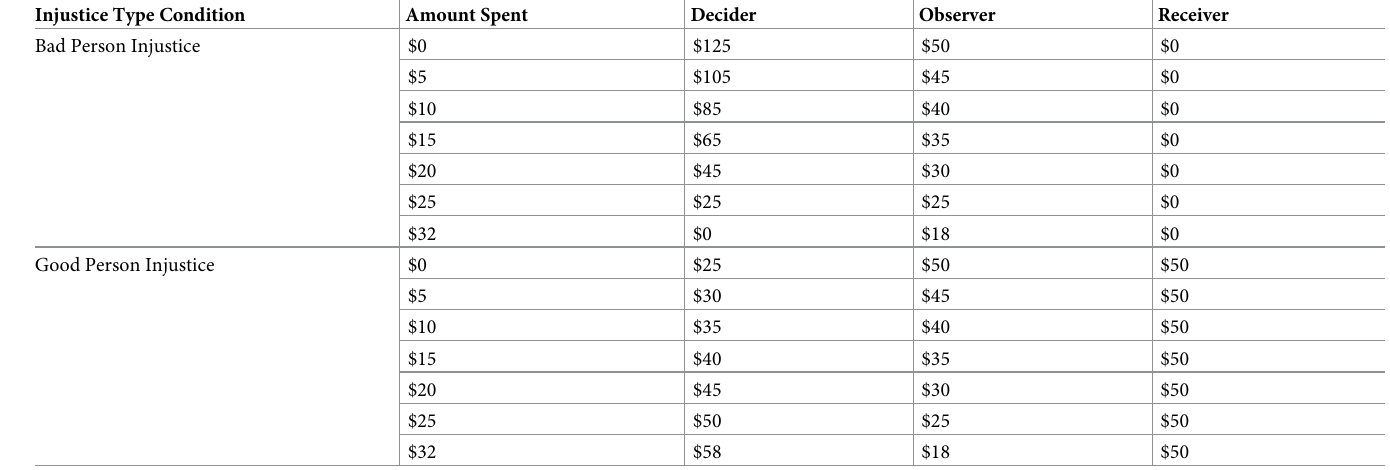
Table 2. Summary of final payouts in Study